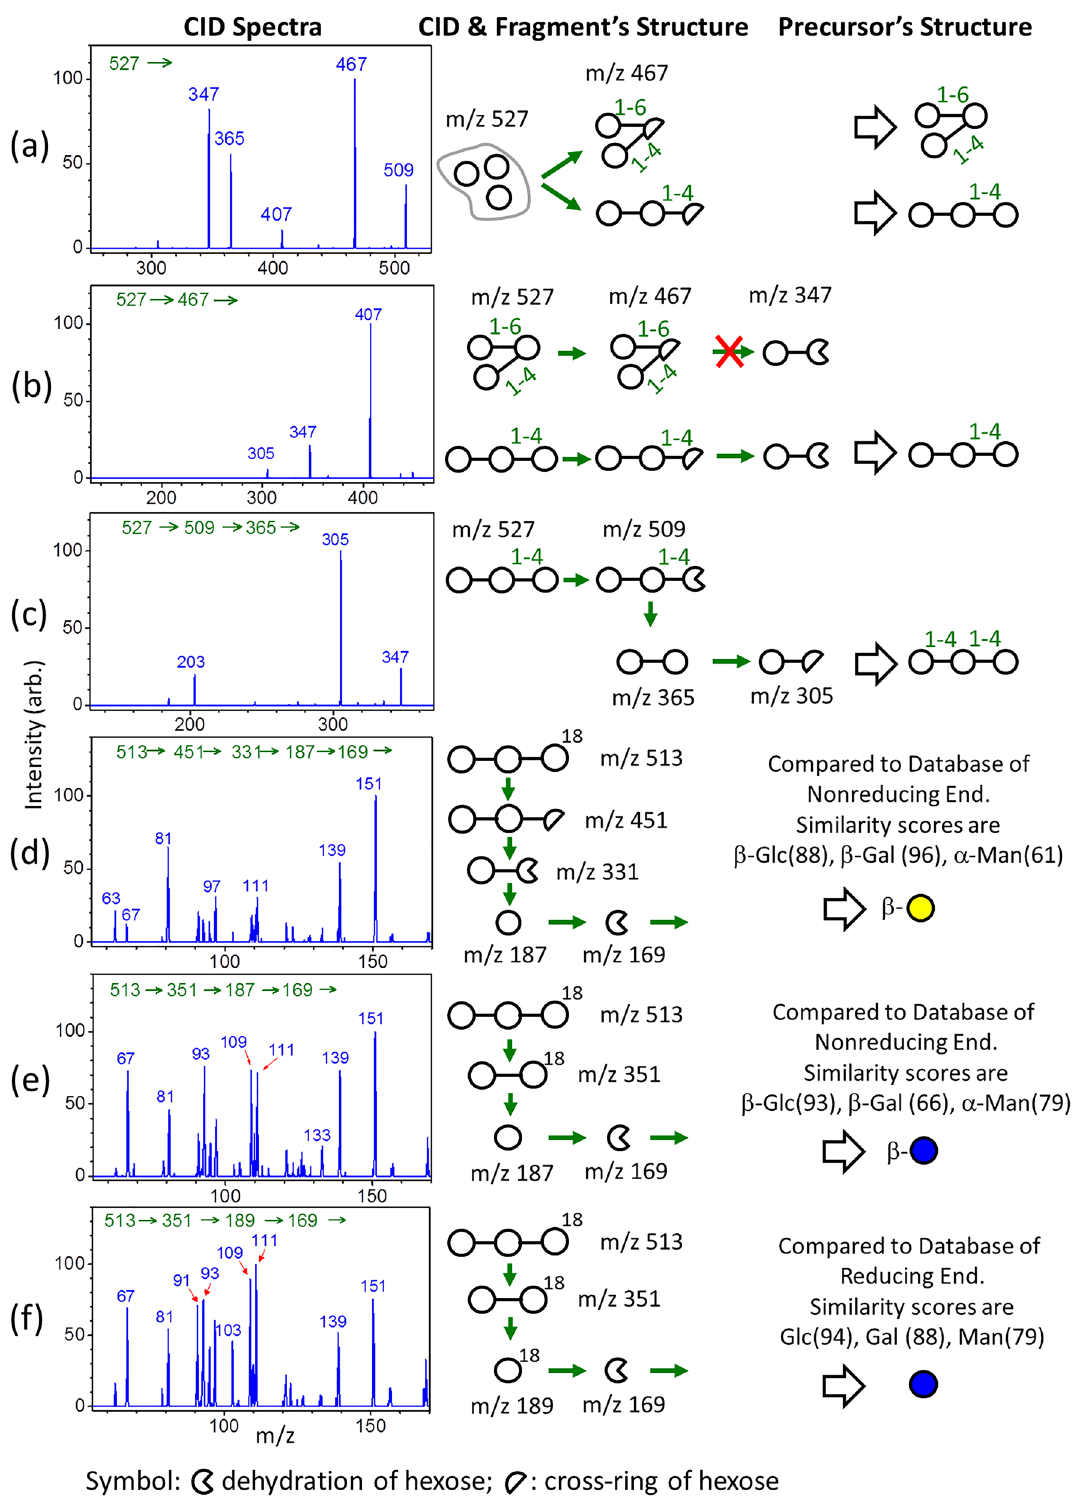
Figure 2. Structural determination of the peak at retention time 40.1 min shown in Fig. 1b by using LODES/ MS n . CID spectra, CID sequence, and possible fragment and precursor structures are illustrated in the left, middle, and right columns of ( a–f ), respectively. Hexoses circulated by gray line in ( a ) represent the linkage between these hexoses are not determined. Green arrows represent